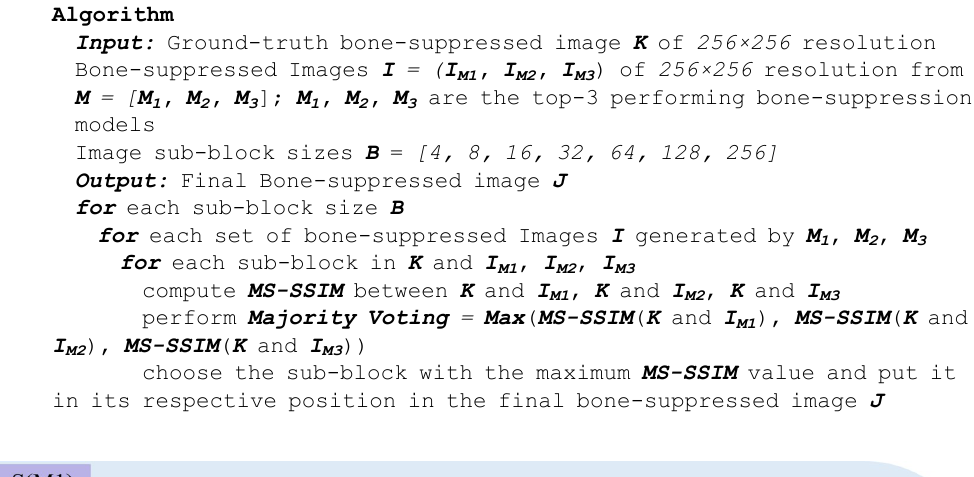
CXR. The predicted image by the individual models is divided into sub-blocks of M × M dimensions. The optimal value of M [4, 8, 16, 32, 64, 128, 256] is determined through extensive empirical evaluations. For a given sub-block size and in each sub-block, the following are per- formed: (i) we measured the MS-SSIM score between the sub-block of the bone-suppressed image predicted by each of the top-3 performing models and the corresponding sub-block in respective ground truth soft-tissue image; (ii) we performed a majority voting for the MS-SSIM score to find that image sub-block with the maximum MS-SSIM score and use it in constructing the final bone-suppressed image. The algorithm below discusses these steps. Fig 5 illustrates the steps involved in constructing the DeBoNet.